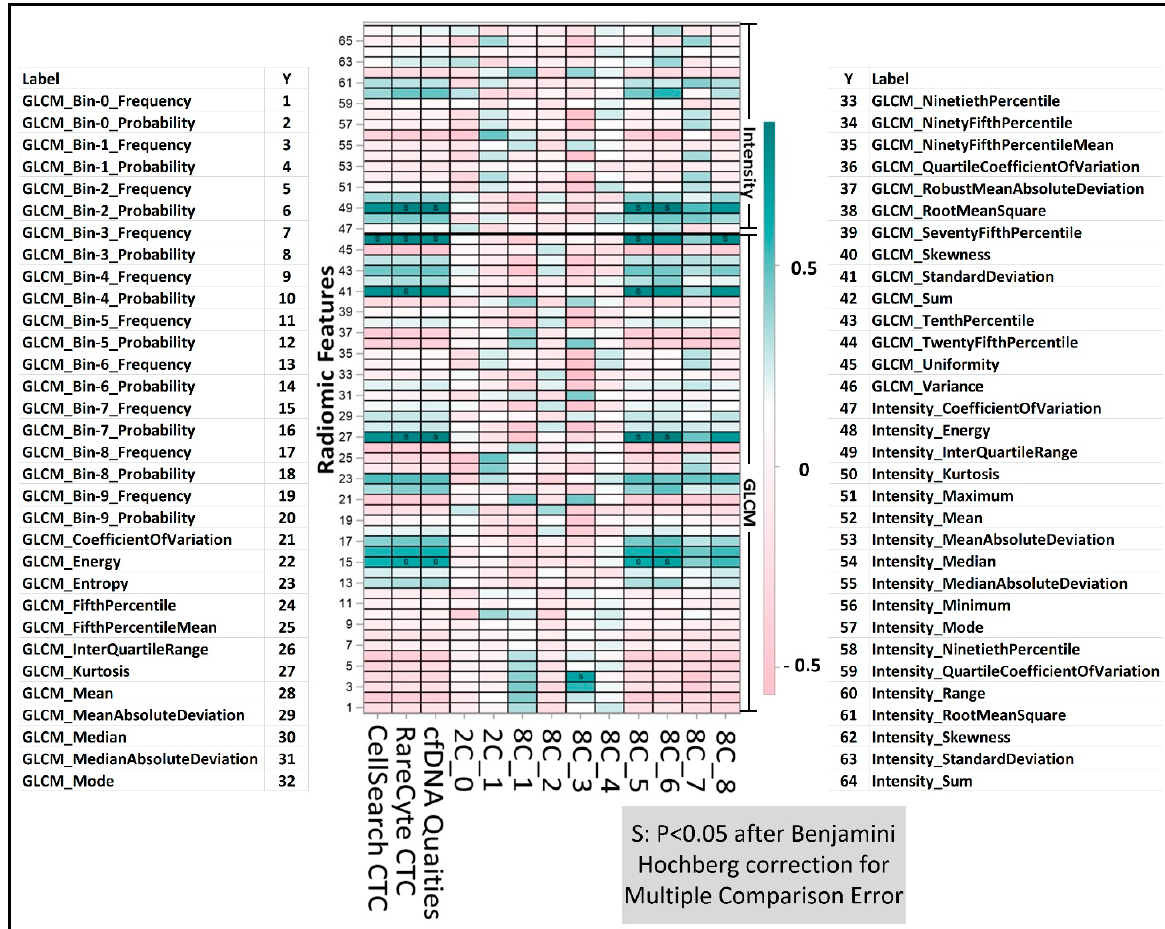
Figure 7. Liquid biopsy correlation with radiomic features. Heatmap representation of the correlation between radiomic panel features and liquid biopsy readouts. Here, c2_0 and c2_1 represent percent of cells belonging to the first or the second cluster of the 2-cluster analysis. c8_1 through c8_8 represent the percent of cells belonging to each of the 8 clusters of the 8-cluster analysis. Color bar depicts the correlation coefficient, a positive number (green) means positive correlation, and a negative number (pink) means negative correlation. Intensity: Signal Intensity Metrics, GLCM: Grey Level Co-Oc- currence Matrix.